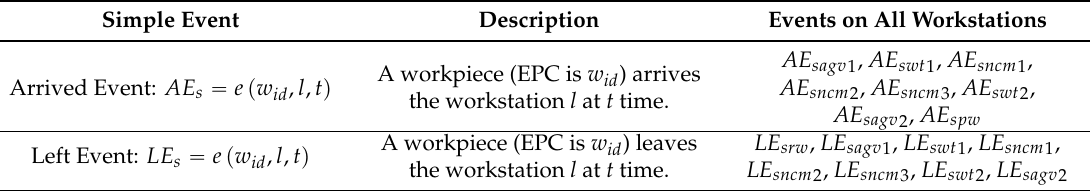
Table 1. Simple events used in this paper.